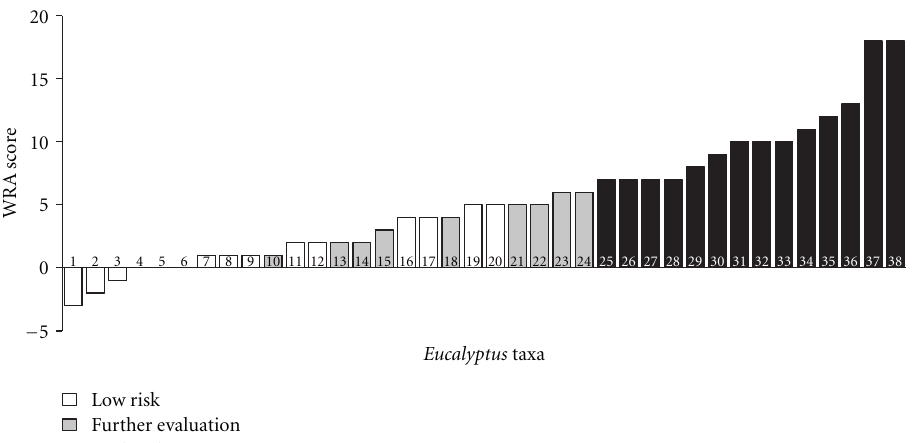
Figure 1: Distribution of Weed Risk Assessment (WRA) scores of 38 Eucalyptus taxa evaluated for the USA. Scores < 1 suggest that the taxon is a low risk for invasion; scores of 1–6 indicate that the taxon requires further evaluation unless a secondary screen [23] allowed resolution to a risk outcome; scores > 6 suggest that the taxon is a high risk for invasion [8]. See Table 1 for identification of the taxon associated with each score. Numbers within bars correspond to numbers in the first column of Table 1.